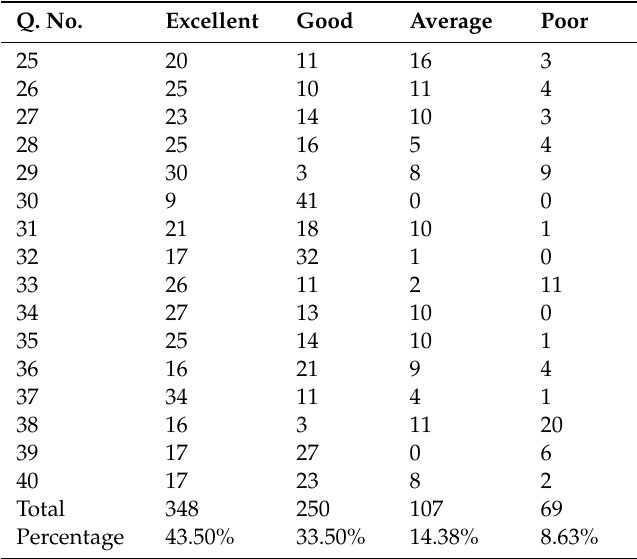
Table 8. Group IV based on Questions 25–40.